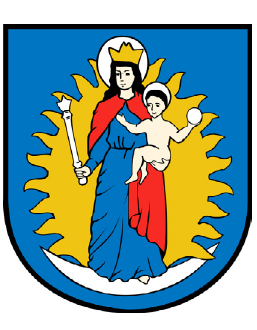
Figure 11. The arms of